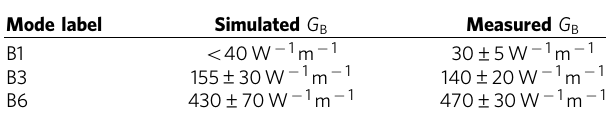
Table 1 | Comparison of measured and simulated Brillouin